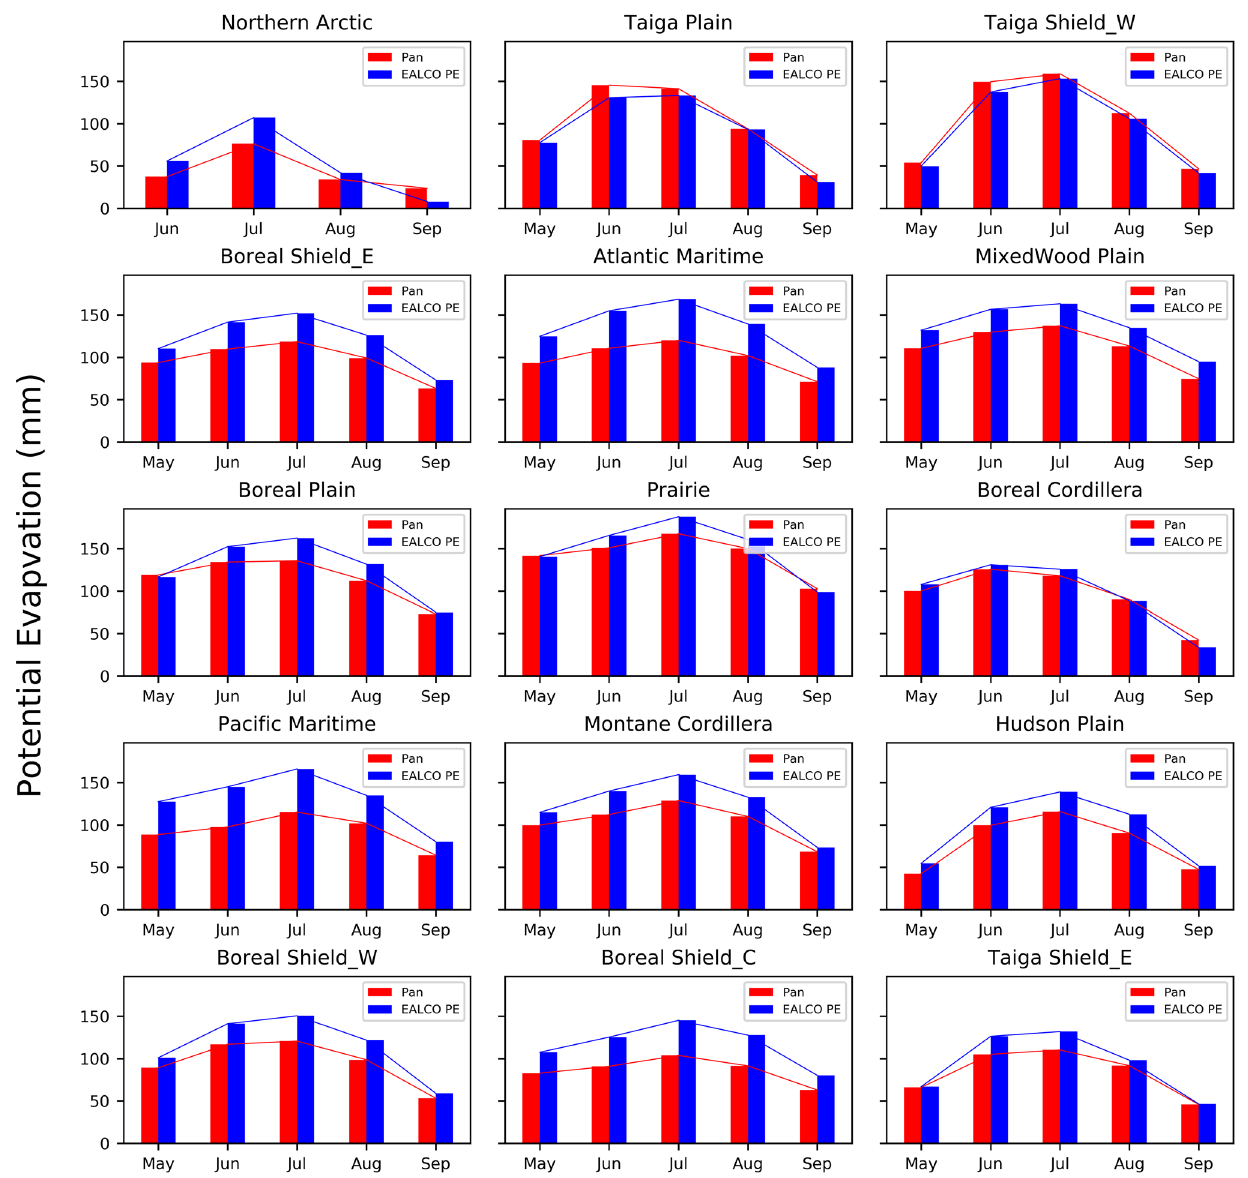
Figure 3. The seasonal variations of monthly EALCO PE (mm) and Pan evaporation (E pan , mm) in May (or June in Northern Arctic) to September 1979 -2007 in 15 ecozones of